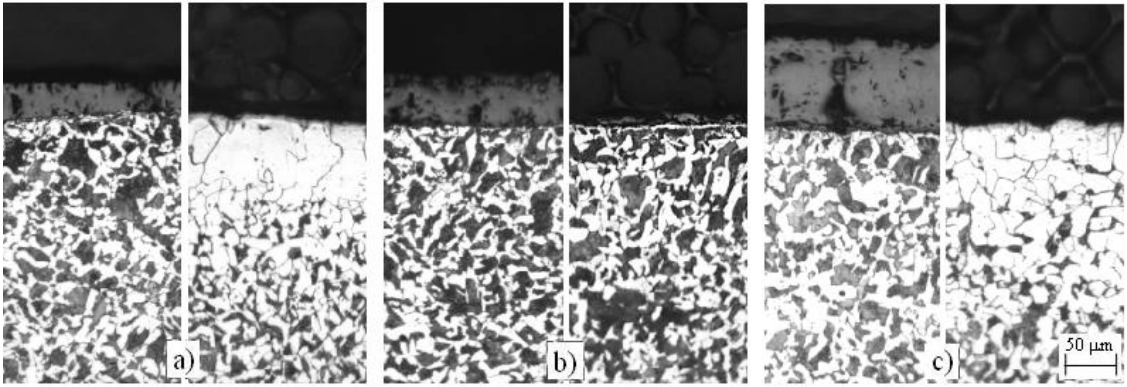
Figure 7. Microstructure of the surface part of C45 steel after annealing at T a = 850 °C. ( a ) t a = ½ h, ( b ) t a = 1 h, ( c ) t a = 2 h. ( b ) t a = 1 h, ( c ) t a = 2